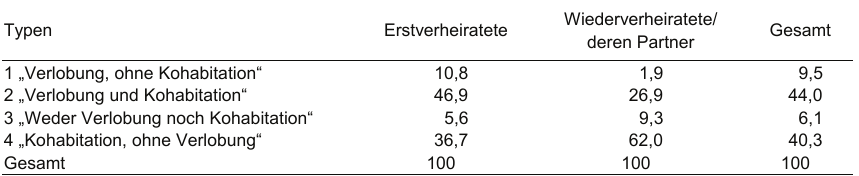
Tab. 6: Typen von Verlaufsmustern der Partnerschaft bis zur Ehe (in %)